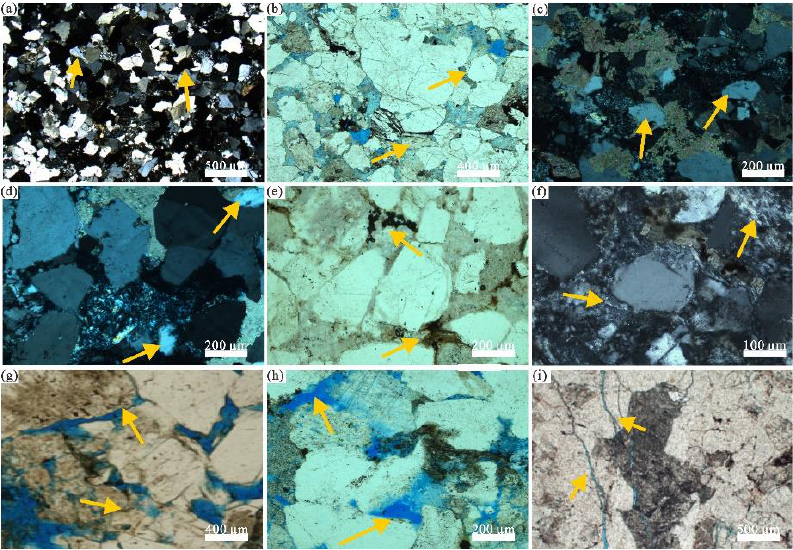
Figure 6. Diagenetic features of the J 1 a sandstone reservoir. ( a ) PPL, grain line contact and stylolite contact (Well YN5, 4922.09 m); ( b ) PPL, grain line contact (Well YN4, 4121.58 m); ( c ) XPL, calcite cement (Well YN4, 4127.69 m); ( d ) PPL, calcite cement (Well YN2, 4841.63 m); ( e ) XPL, quartz over- growth (Well DX 1, 4854.32 m); ( f ) PPL, quartz overgrowth (Well DB 102, 5004.39 m); ( g ) PPL, feldspar overgrowth (Well DX 1, 4858.74 m); ( h ) PPL, feldspar dissolution (Well YN2, 4839.26 m); ( i ) PPL, structural fractures (Well YN5, 4839.86 m). PPL—plane-polarized light; XPL—cross-polarized light.